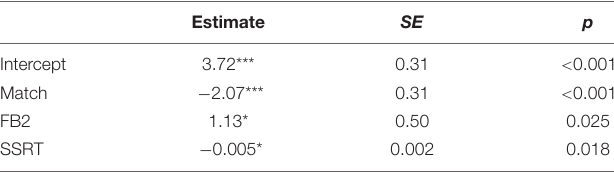
TABLE 6 | Estimated multiple mechanisms model of accuracy in object pronoun